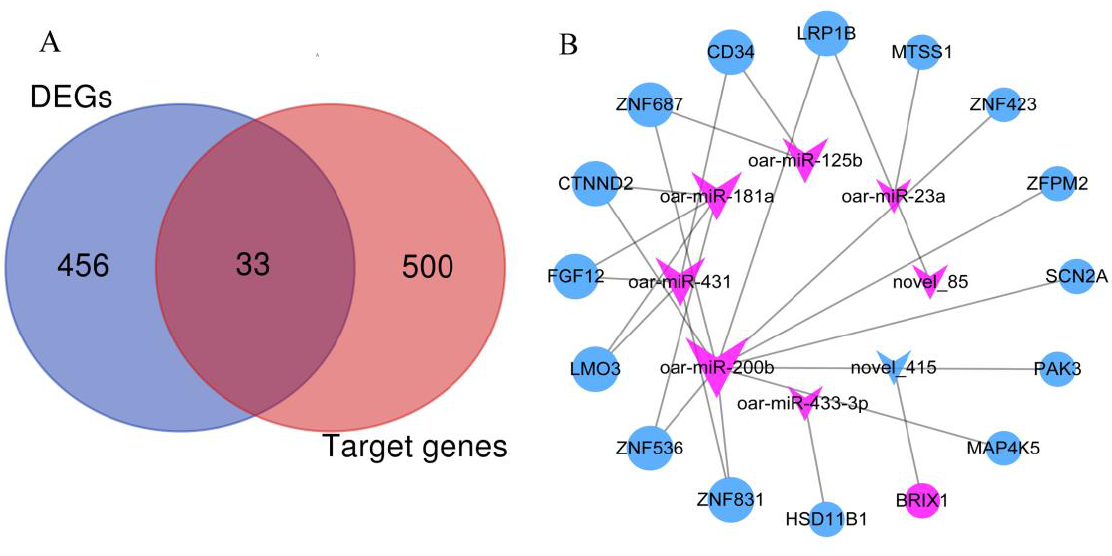
Figure 6. Co-expression network of miRNA-mRNA. ( A ) Overlapped genes between DE genes and target genes. ( B ) The interaction network of miRNAs and overlapped genes in SM vs. ST. “v” sharp represents DE miRNAs and circle represents overlapped genes. Red represents up-regulated miRNAs or genes and blue represents down-regulated miRNAs or genes.